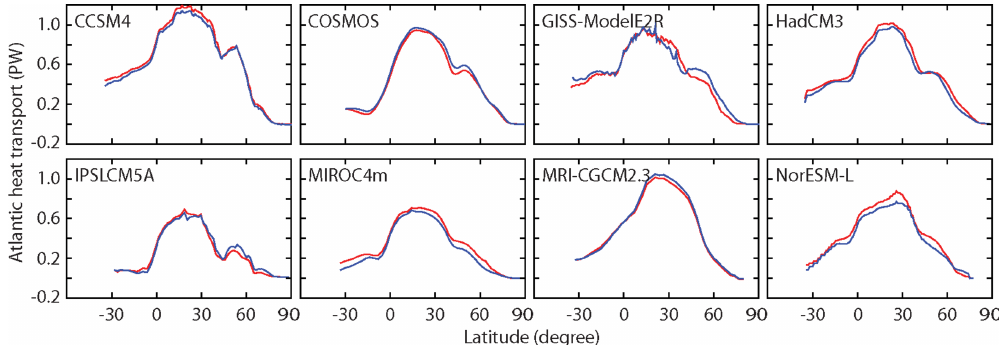
Fig. 4. Comparison of pre-industrial (red) and mid-Pliocene (blue) Atlantic northward ocean heat transport (PW) simulated in the PlioMIP.